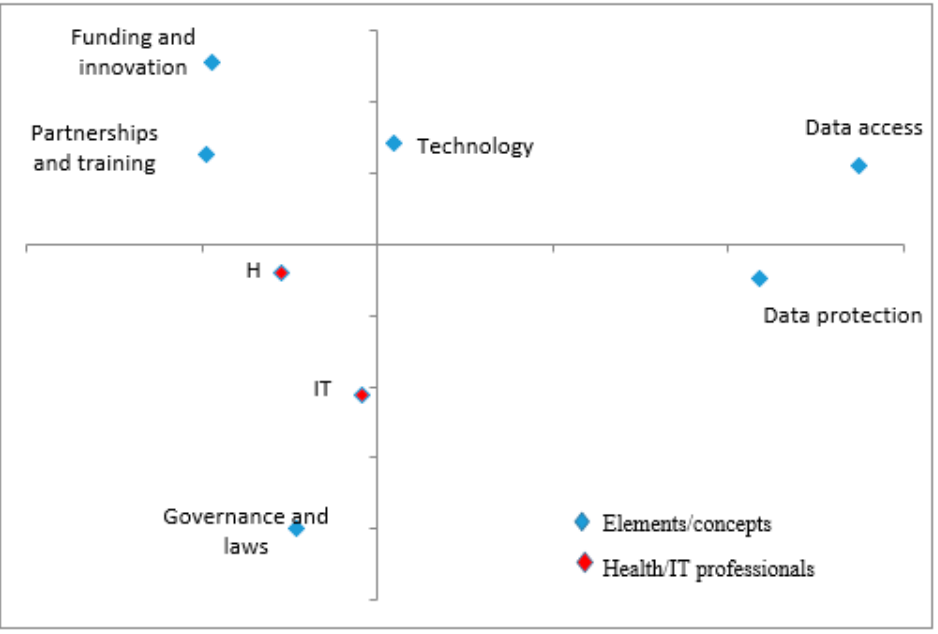
Figure 6. Solutions to Challenges of Big Data Technologies.